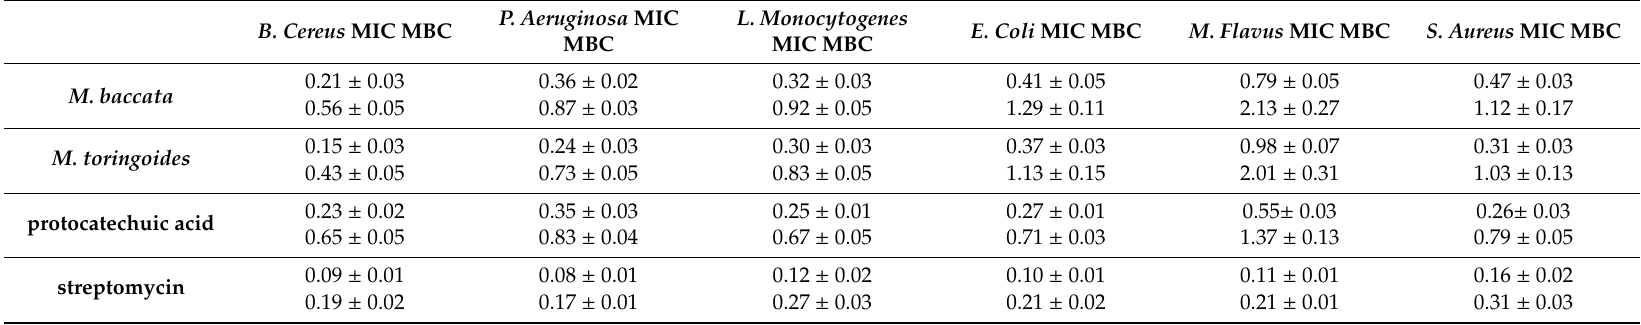
Table 4. Malus baccata and Malus toringoides bark extracts and protocatechuic acid antibacterial activities by means of minimum inhibitory (MIC) and bactericidal concentration (MBC). Values are means of 3 replicates.